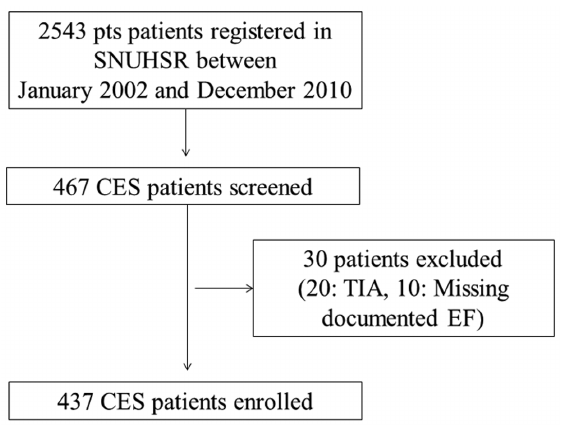
Figure 1. Flow chart of patient enrollment. Abbreviations: SNUHSR: Seoul National University Hospital Stroke Registry, CES: Cardio-embolic stroke, TIA: Transient ischemic attack, EF: Ejection Fraction.